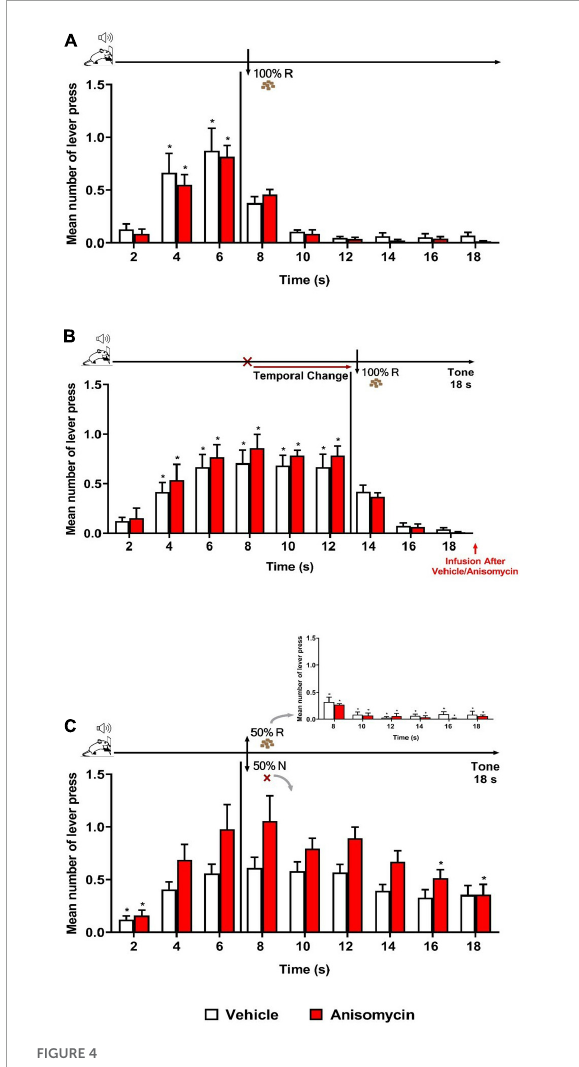
FIGURE4 Anisomycin infusion after the Error session interfered with long-term memory of temporal updating. Responses average (+ SEM) during the 18 s tone, per 2 s, for Vehicle (White columns; n = 8) and Anisomycin (Red columns; n = 7) groups. (A) Retraining session during FI 6 s LH 12 s signaled schedule (* p < 0.05, intra-group differences from 2 s). (B) Error session of Temporal Change during FI 12 s LH 6 s signaled schedule during which the FI time was changed from 6 to 12 s to obtain the reward, and vehicle or anisomycin infusions were performed immediately after session (* p < 0.05, intra-group differences from 2 s). (C) Reinforcement omission effect (ROE) Test session under FI 6 s LH 12 s during which the reinforcement was omitted in 50% of trials (* p < 0.05, differences from 6 s). FI, fixed-interval; LH, limited hold; R, Reinforcement; N,